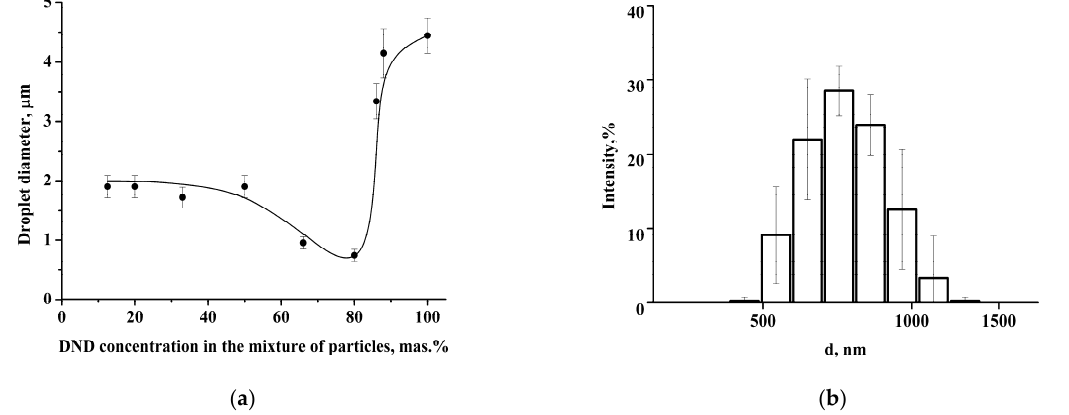
Figure 5. ( a ) Dependence of the Pickering emulsion droplet size on the DND content in the mixture of the nanoparticles; ( b ) size distribution of the Pickering emulsion droplets at 80 wt.% of DNDs in the mixture of nanoparticles.